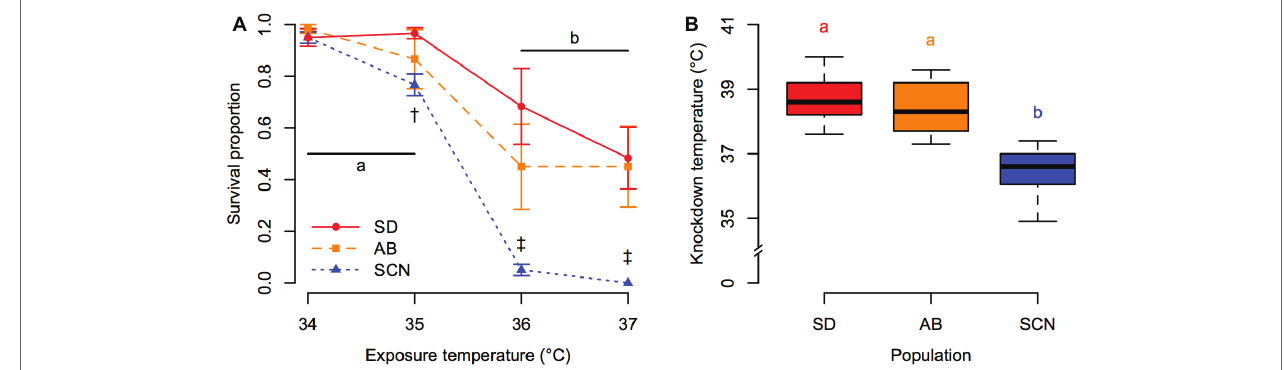
FIGURE 2 | Acute upper thermal tolerance assessed by survivorship of 1-h heat stress (A) and knockdown temperature (B) in San Diego (SD; red, circles, solid lines), Abalone Cove (AB; orange, squares, dashed lines), and Santa Cruz (SCN; blue, triangles, dotted lines) copepods. (A) Data are presented as mean ± SEM; shared letters indicate temperatures that are not significantly different within populations; dagger symbols indicate differences among populations within a temperature († = SCN different from SD, ‡ = SCN different from SD and AB). (B) Data are presented as box plots; shared letters indicate populations that do not differ